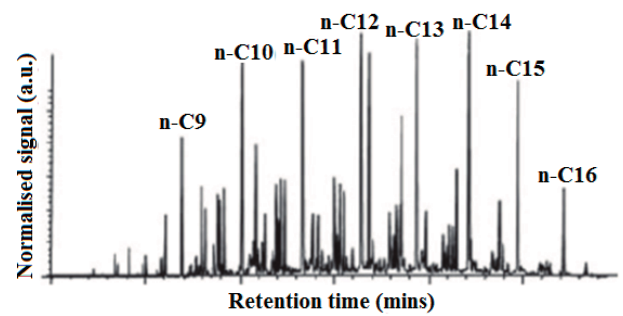
Figure 1. Gas chromatography of typical composition of Jet A-1 4